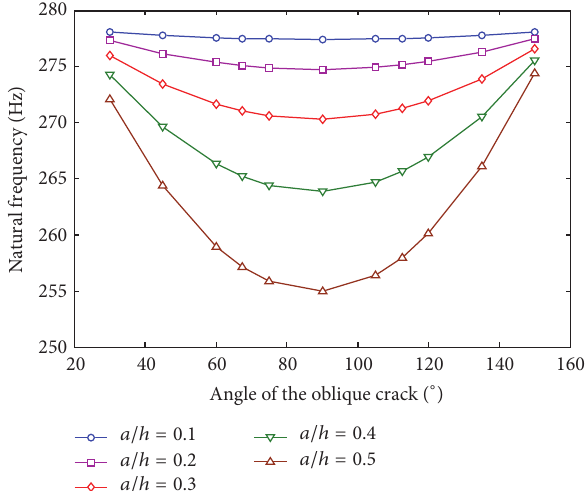
Figure 12: Natural frequencies of the breathing oblique crack with different relative depths.